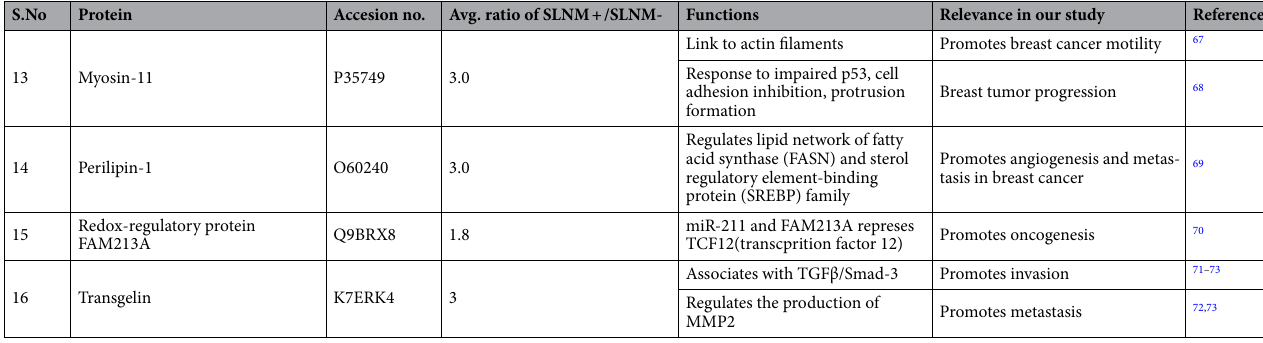
Table 2. Proteins up-regulated in tissue of sentinel lymph node with metastasis as compared to sentinel lymph node without metastasis.